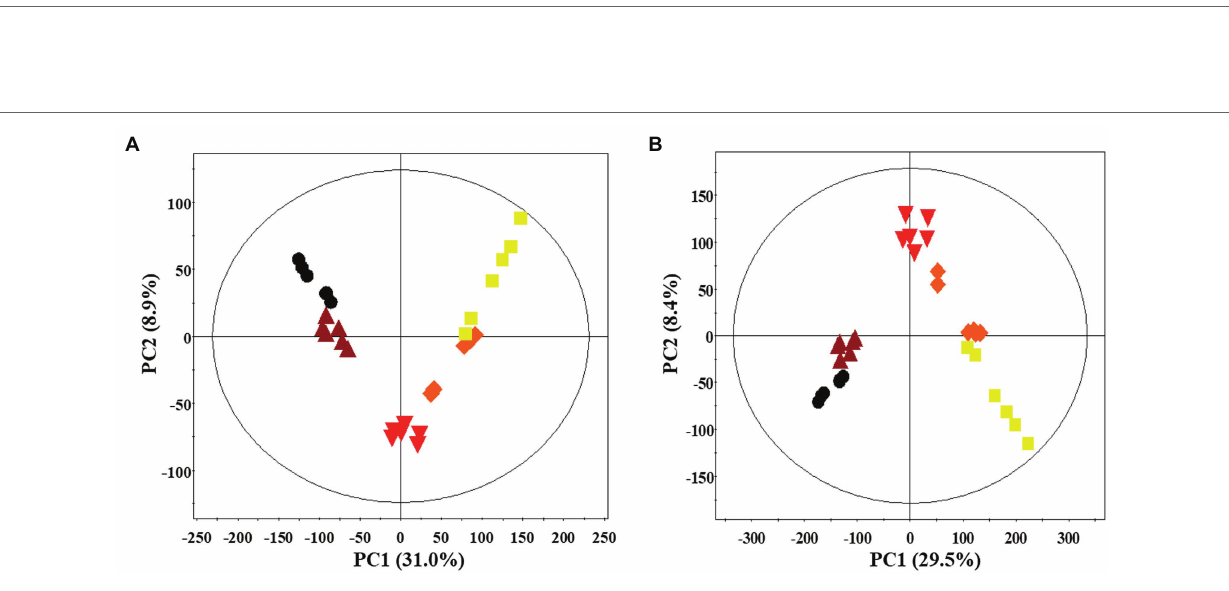
FIGURE 2 | Principal component analysis (PCA) score plot of P. notoginseng during SSF-P derived from the GC-TOF-MS (A) and UHPLC-Q-orbitrap-MS (B) data sets. , day 0; , 2 d; , 4 d; , 6 d; , 8